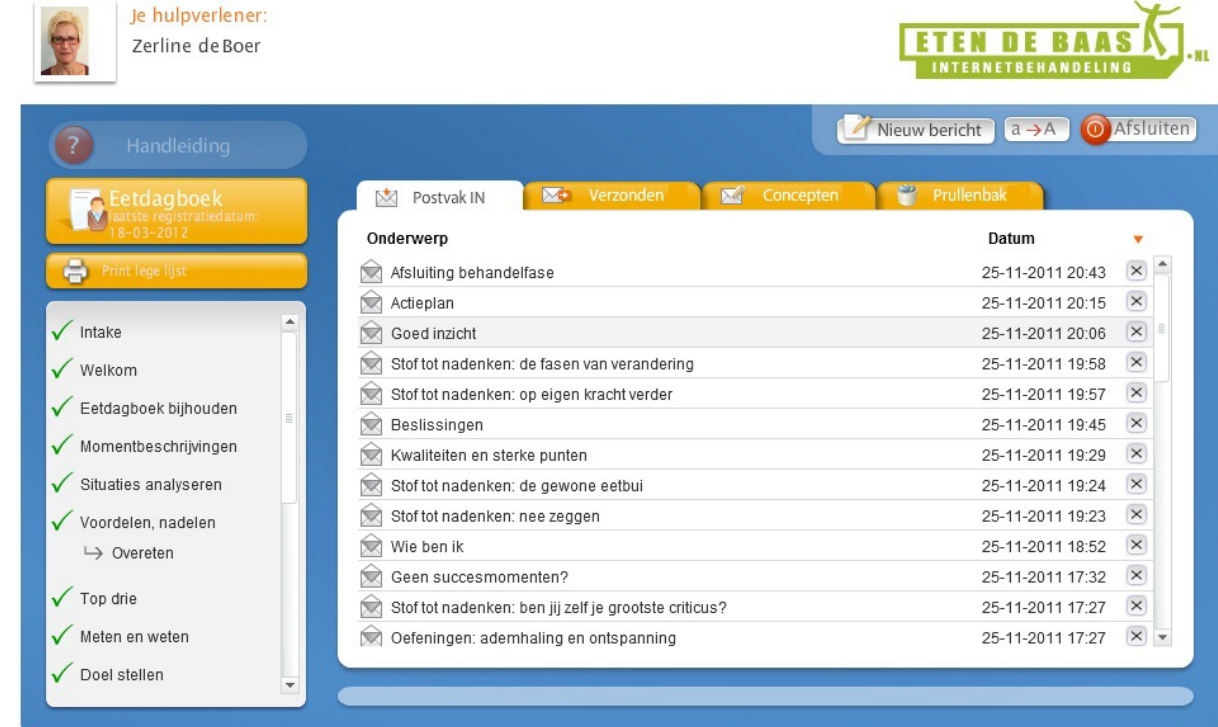
Figure 2. Participant's personal online